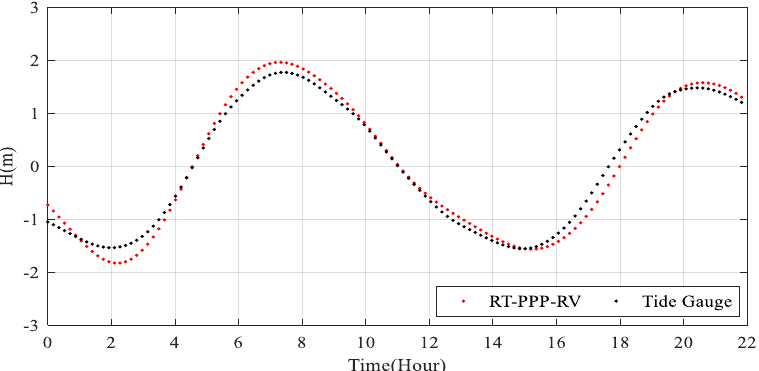
Figure 14. The RT-PPP tide measurement results with respect to the tide gauge data. Table 7. Comparison of the RT-PPP tide measurement results with the tide gauge data. Bias(m) Compared Methods RMS(m) Max Average RT-PPP - Tide 0.343 0.141